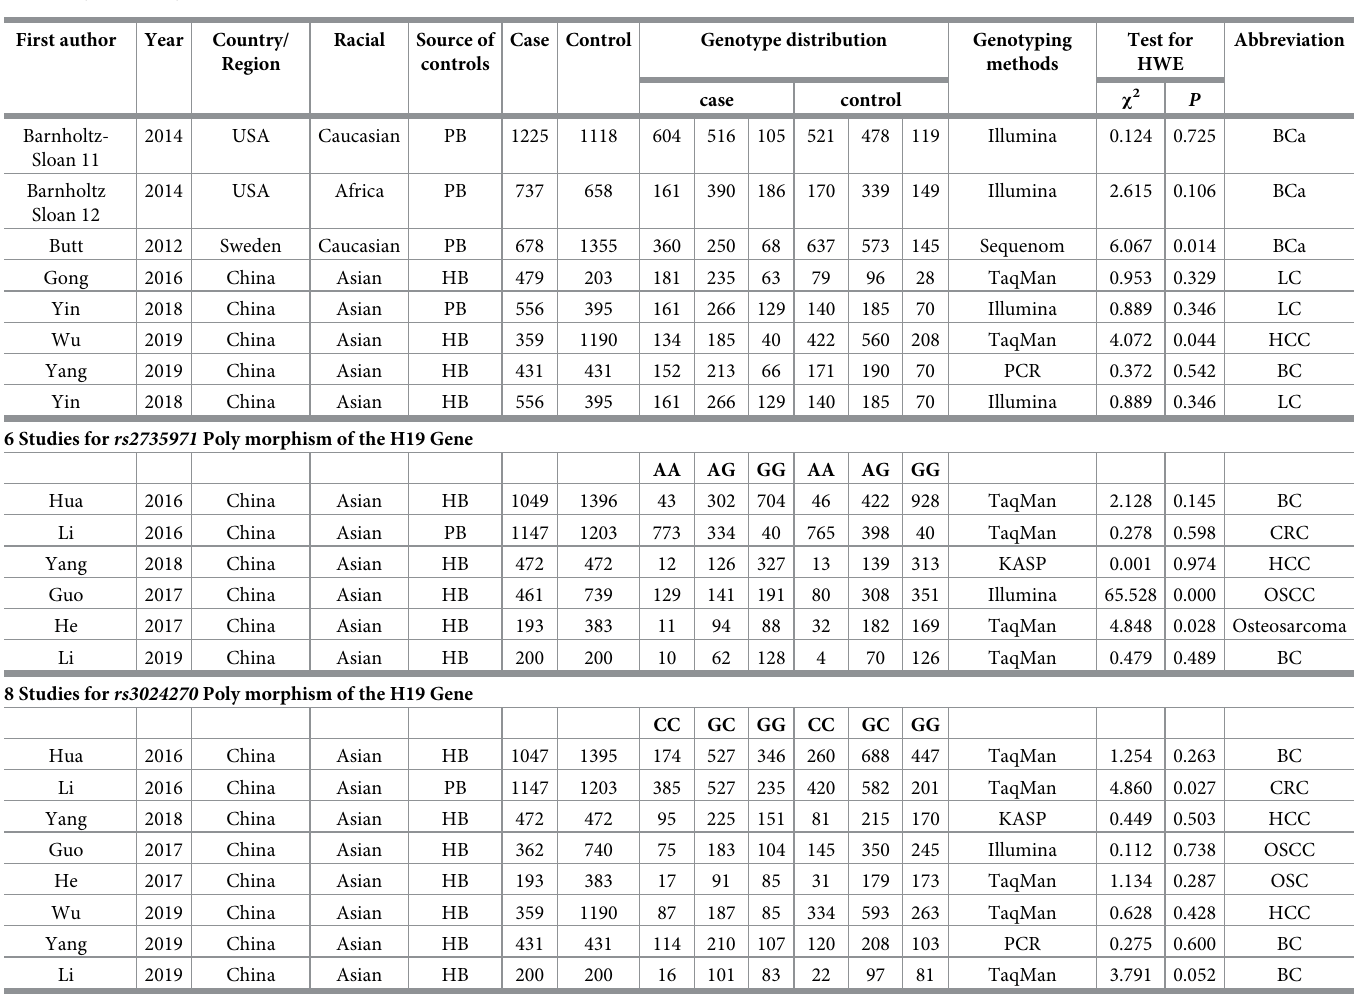
analysis by genotypic